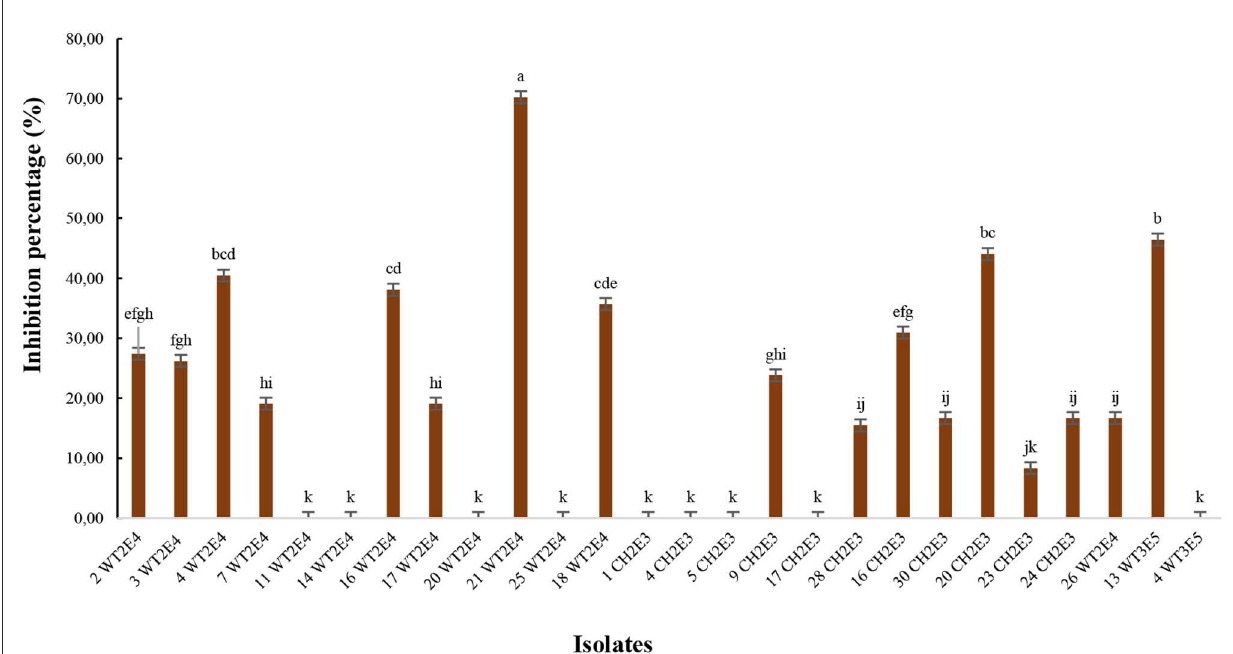
FIGURE7 Antifungal effect of bacterial isolates against F. oxysporum . Different letters indicate that values are statistically different at a P -value of ≤ 0.05.